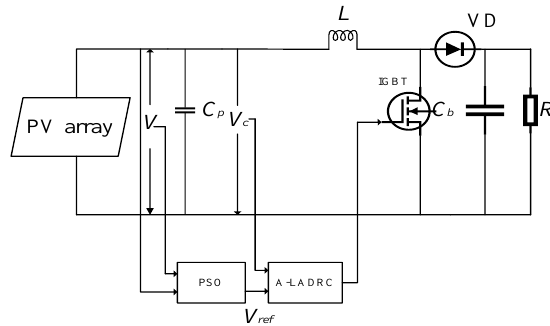
Figure 2. Structure of MPPT control scheme.